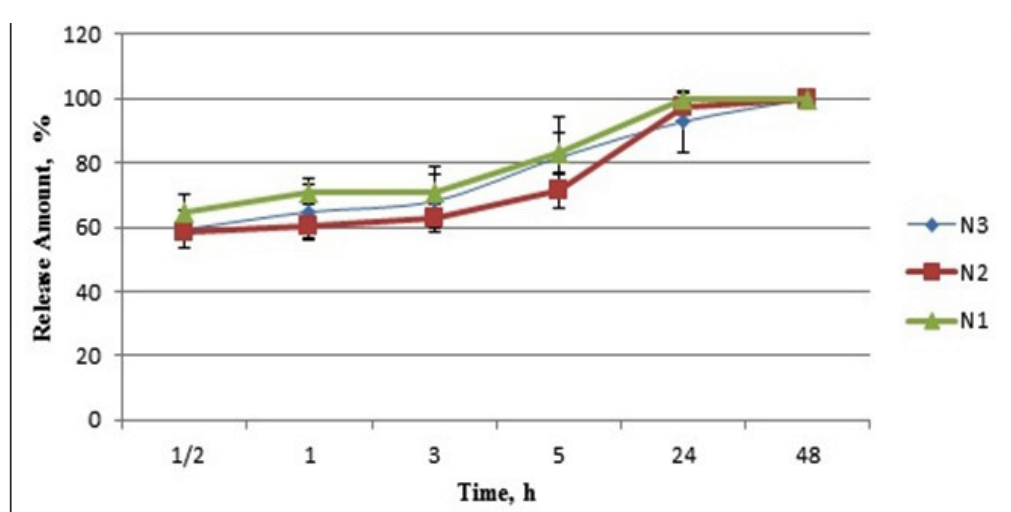
O particles the main characteristic peaks of 3 4